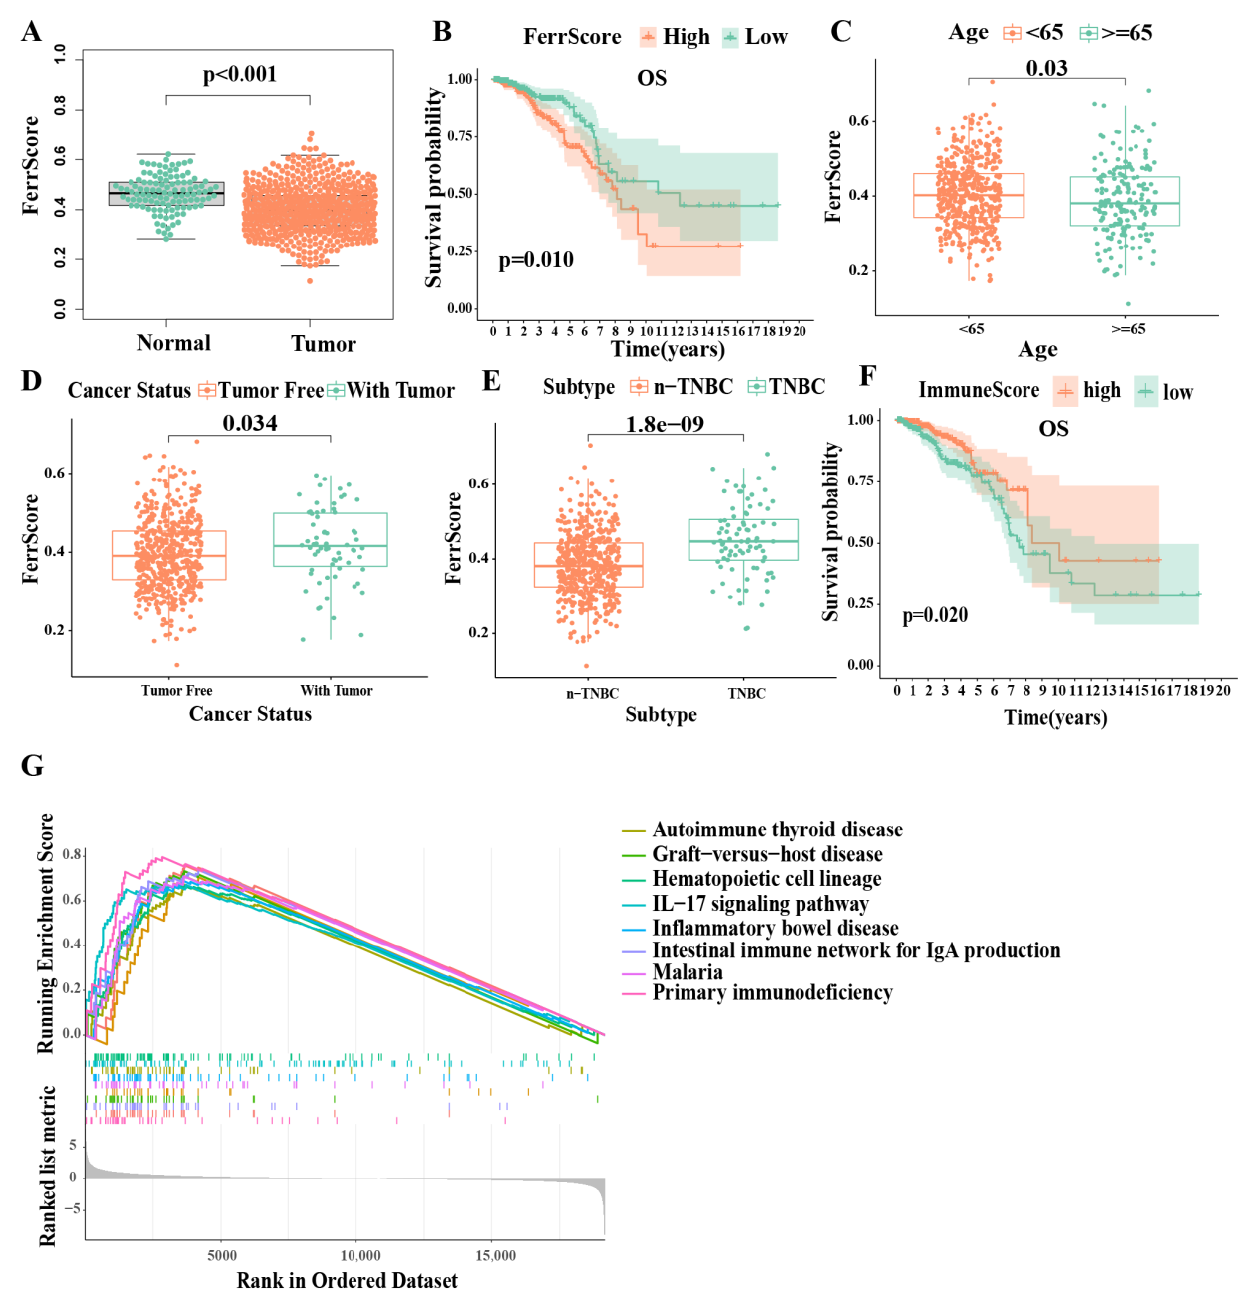
Figure 1. IDC ferroptosis and immune-landscape: The ssGSEA and ESTIMATE algorithms were used to evaluate the ferroptosis score (FerrS) and immune score (ImmS) in IDC samples. ( A ) FerrS in IDC and normal groups; ( B ) Kaplan–Meier overall survival curves for patients (n = 660) in high- and low − FerrS groups; ( C – E ) The difference of FerrS in clinical features; ( F ) Kaplan–Meier overall survival curves for patients (n = 660) in high- and low − ImmS groups; ( G ) GSEA KEGG enrichment analysis between high − and low − FerrS